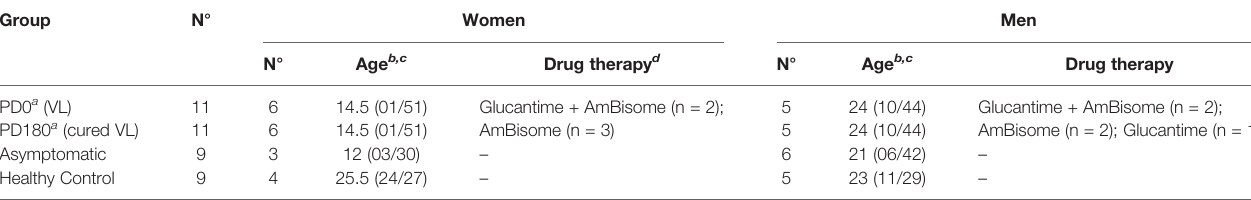
TABLE 1 | General information of the groups analyzed in this